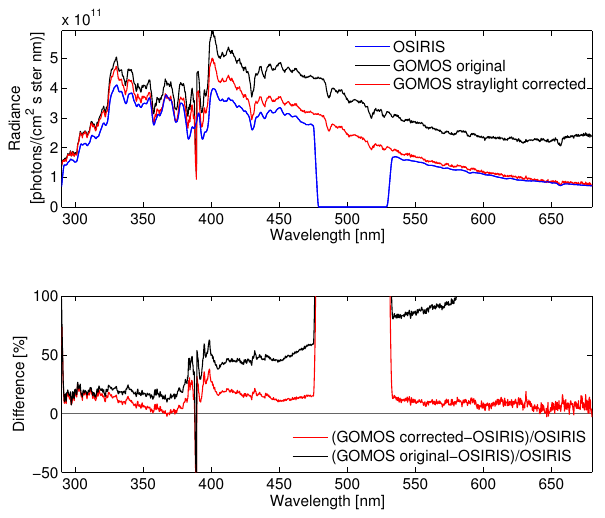
Fig. 5. Example of absolute radiances from GOMOS and OSIRIS. Upper panel: radiances at 55km. Lower panel: relative differences.